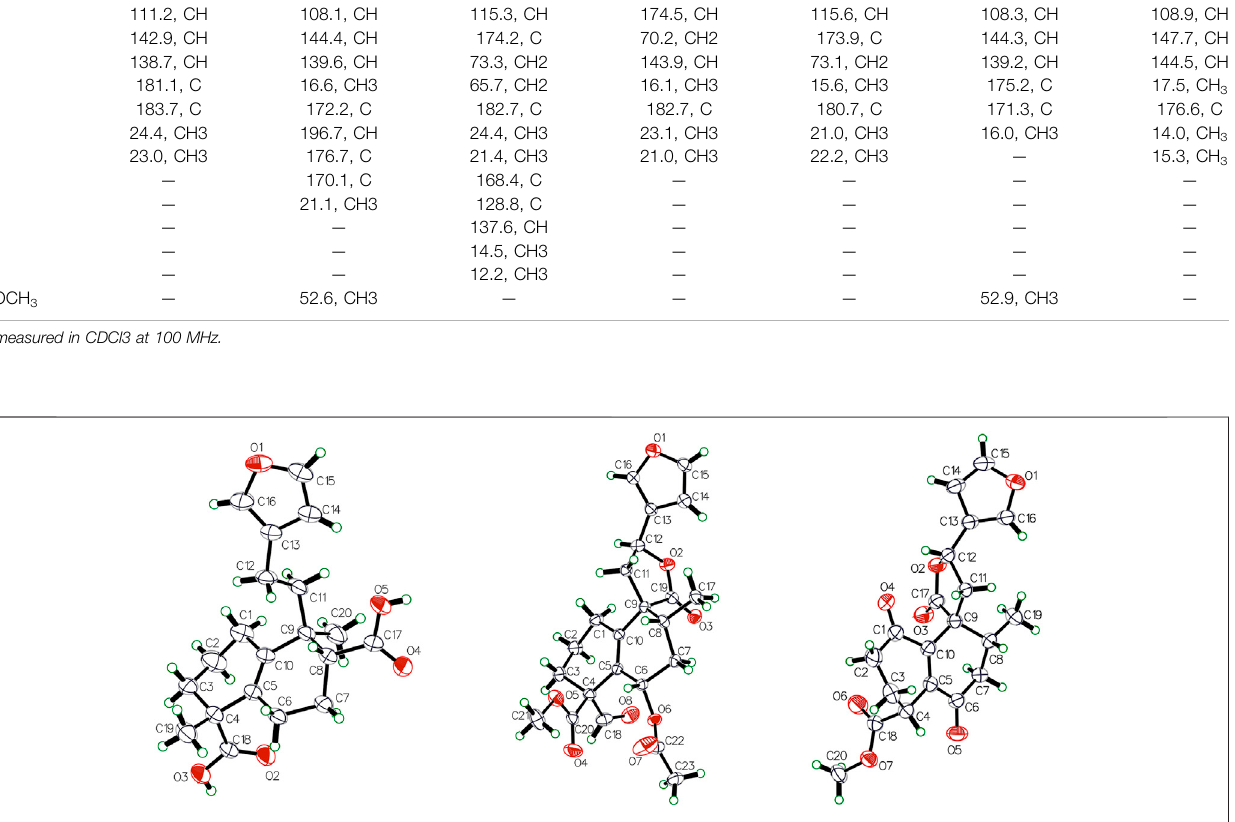
Frontiers in Chemistry |